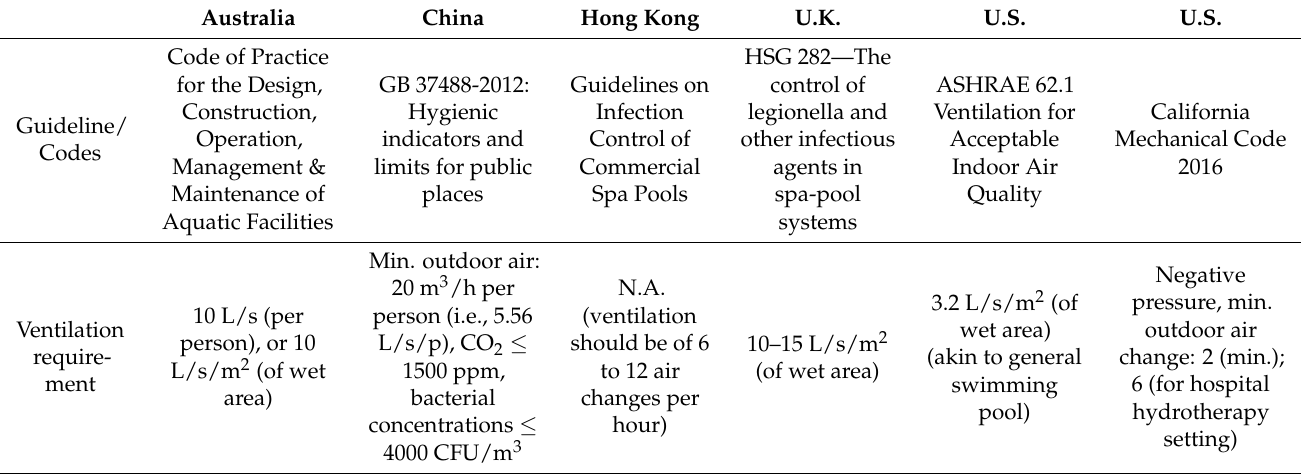
Table 2. Ventilation requirements for spa pools or similar